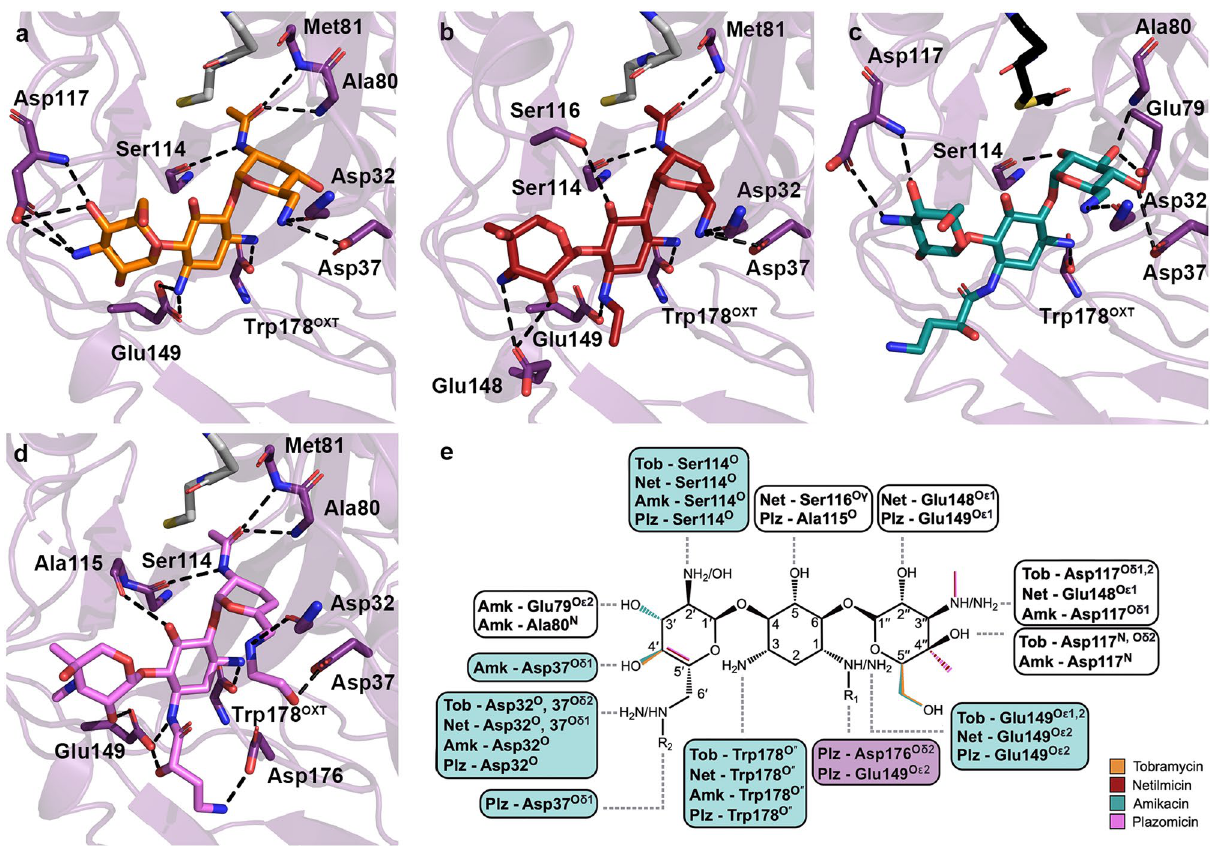
Figure 4. Interactions of naturally occurring, semi-synthetic aminoglycosides, and plazomicin to AAC(2 ′ )-Ia. Depicted in panels ( a ), ( b ), ( c ), and ( d ) are the hydrogen bond interactions for acetylated tobramycin, acetylated netilmicin, amikacin, and acetylated plazomicin, respectively. Aminoglycosides are colored as in Fig. 3. The acetylated or non-acetylated β-mercapto-ethylamine moiety of acetyl-CoA and CoA ligands are shown for perspective, and are colored in either black or grey, respectively.( e ) A combined chemical structure for all four aminoglycosides is shown Features unique to each aminoglycoside are highlighted based on the previous panel’s color scheme. Hydrogen bond interactions are depicted in boxes. Blue boxes indicate the four conserved sites involved in critical hydrogen bond interactions, and white boxes indicate interactions that occur less frequently. The box for the residues critical for plazomicin hydrogen bonding is colored in